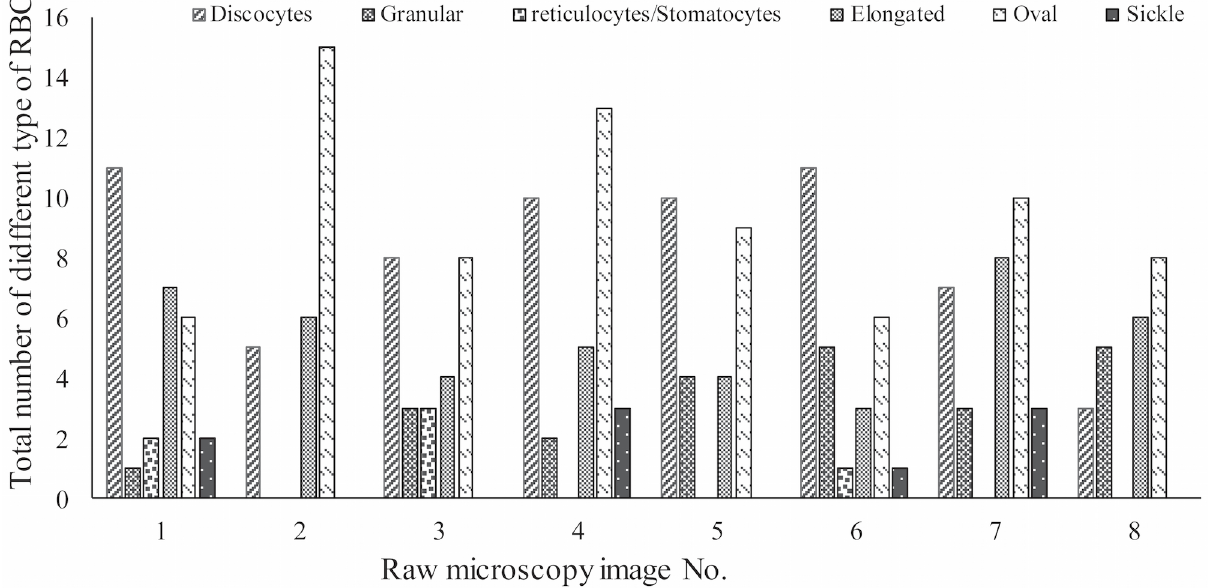
Fig 17. Statistical quantification for the number of various types of RBCs in density fraction 4 (severeSCD). Notice the significant heterogeneity of cell types even at the highest density fraction.